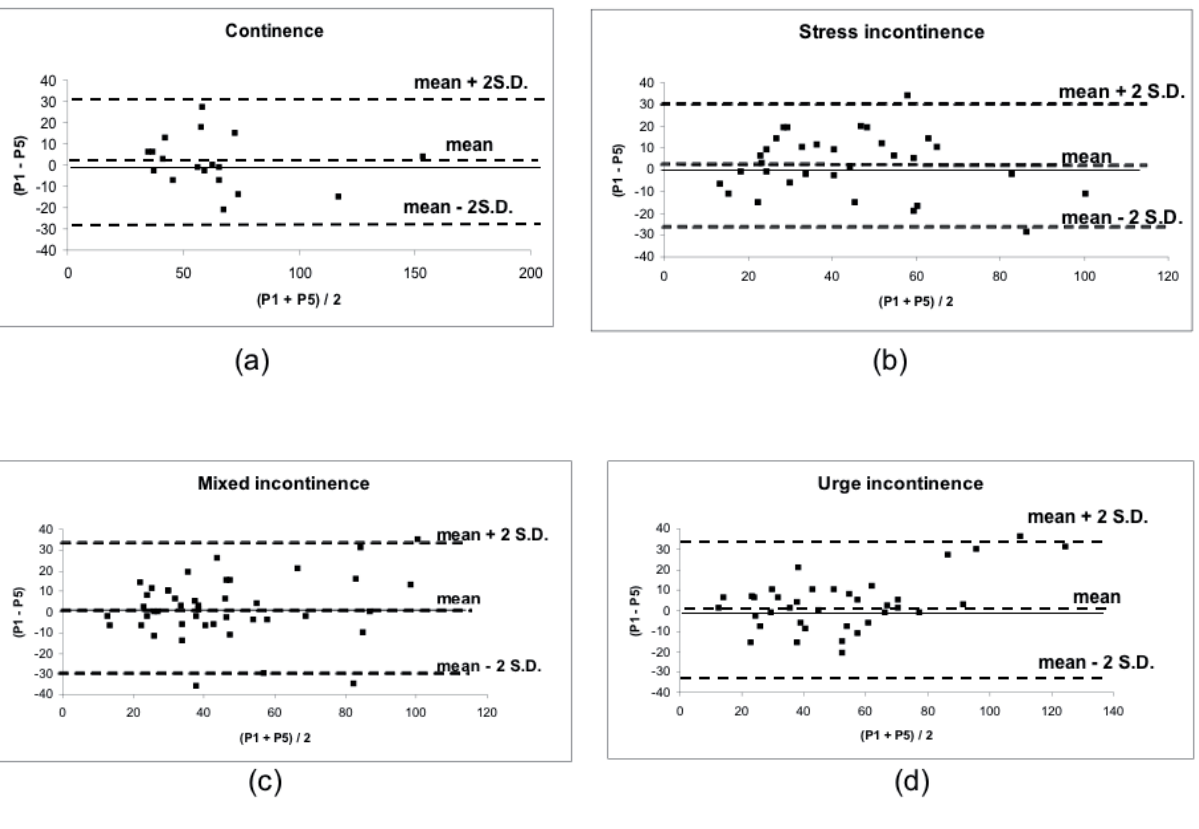
Figure 1 - Assessment of measurements reproducibility. Bland and Altman plots (15) for MUCP value at rest (empty bladder) in supine position. (P1): fi rst measurement bladder fi lled, (P5): before fatigability test. (a) continent women, (b) women with stress incontinence complaint, (c) women with mixed incontinence complaint, (d) women with urge incontinence